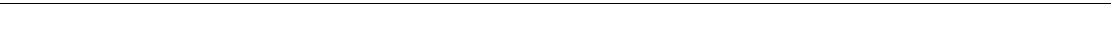
Table 5. Summary of Articles Related to Sense of Community Among Shoppers with Non-Specified